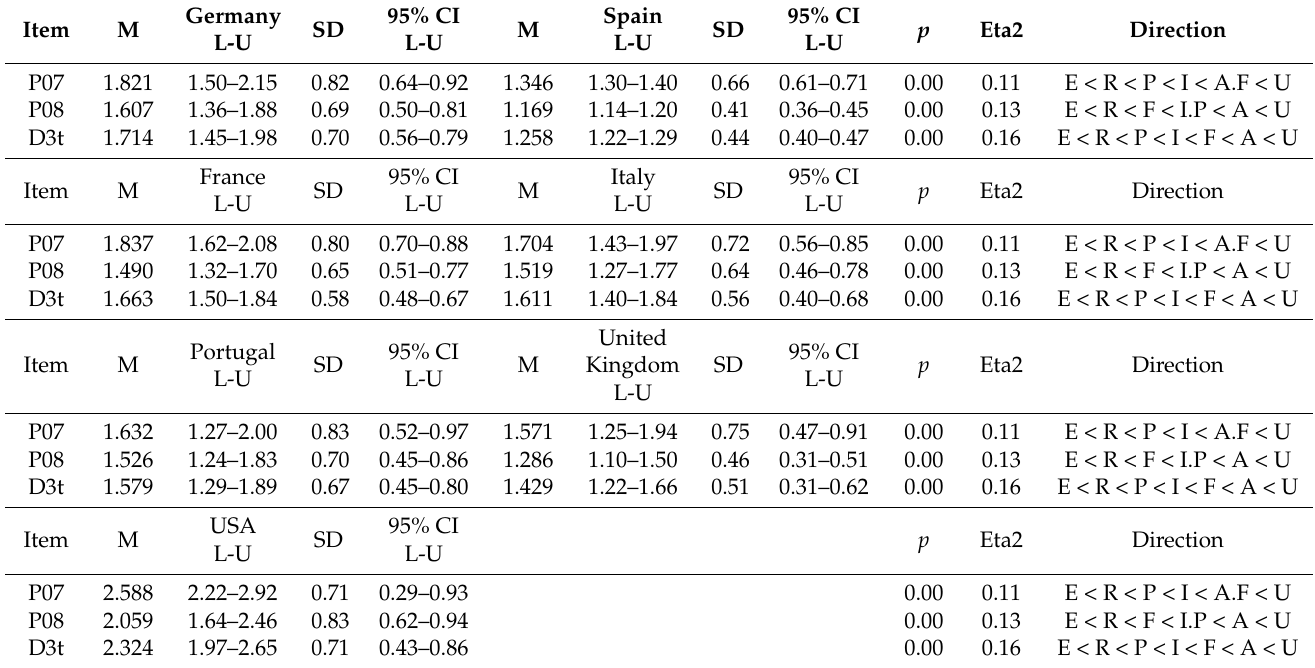
Table 15. ANOVA for independent samples by country (M, SD from Germany, Spain, France, Italy, Portugal, United Kingdom, and U.S.A.) for dimension